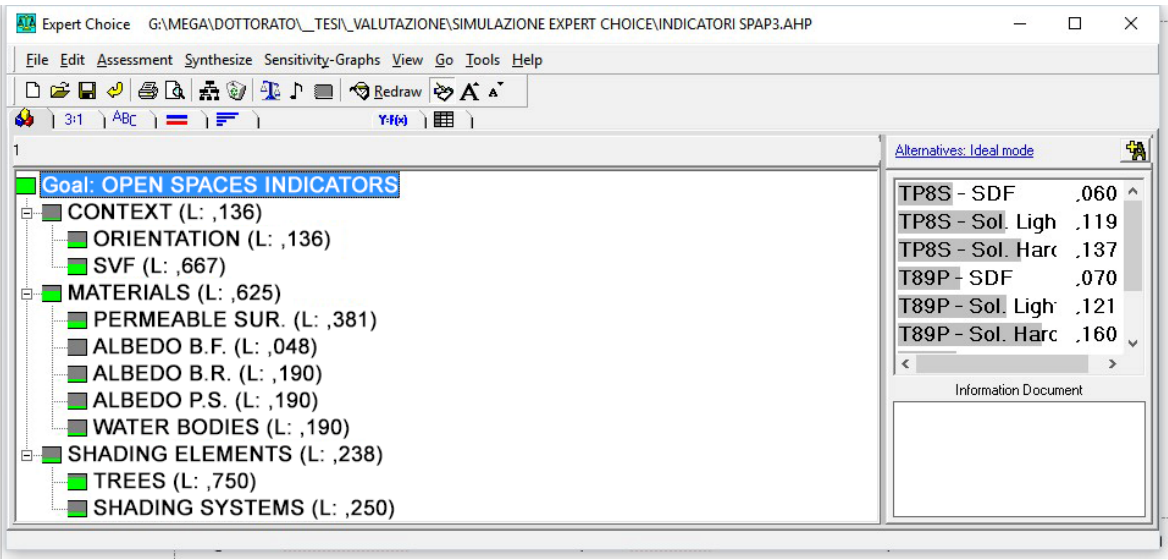
Figure 18. Definition of the decision-making problem by assigning the weight to criteria and indi- cators.